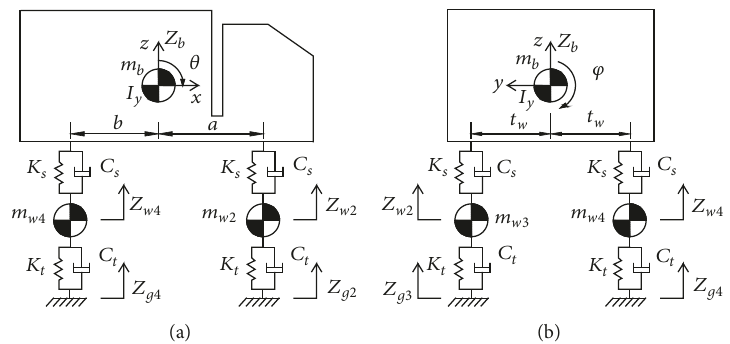
Figure 1: Simplified vehicle model with 7 DOFs: (a) side view and (b) back